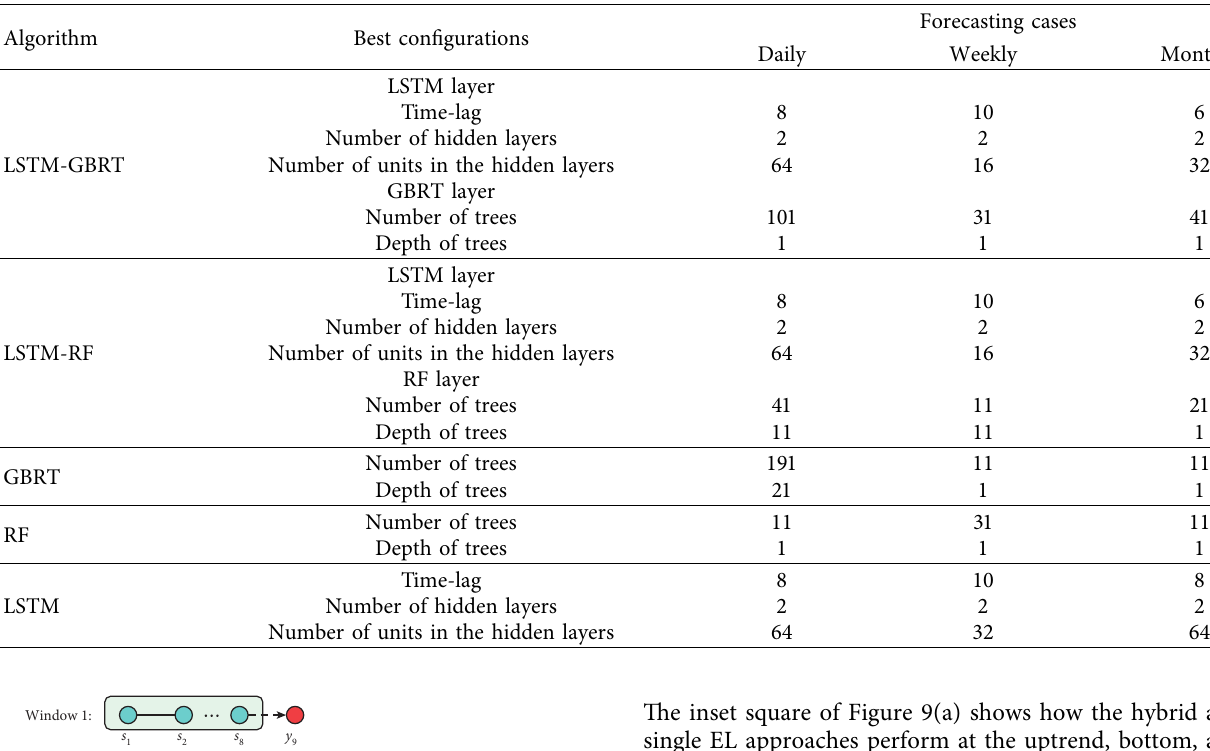
Table 4: The best configurations of the proposed model and benchmark models. Algorithm